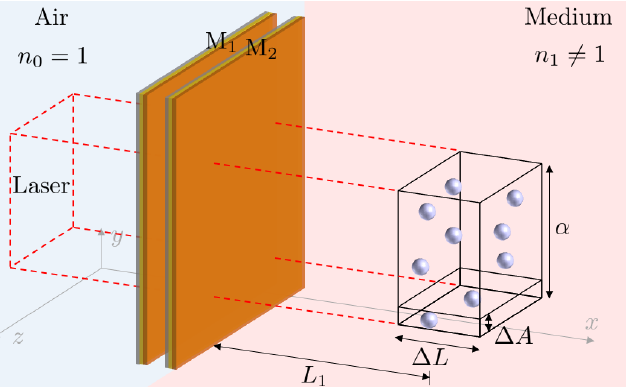
b Figure 11. An alternative view on the remote Fabry-Pérot cavity sensor in Figure 2. Here, the target molecules are randomly distributed within a volume V of length ∆ L a distance L 1 away from the resonator. Moreover, ∆ A and α denote the cross section of a single molecule and α is the area that the incoming laser light excites. Our hypothesis here is that the molecules closely resemble tiny semitransparent mirrors, which suggest the same optical response of the above experimental setup and the experimental setup shown in Figure